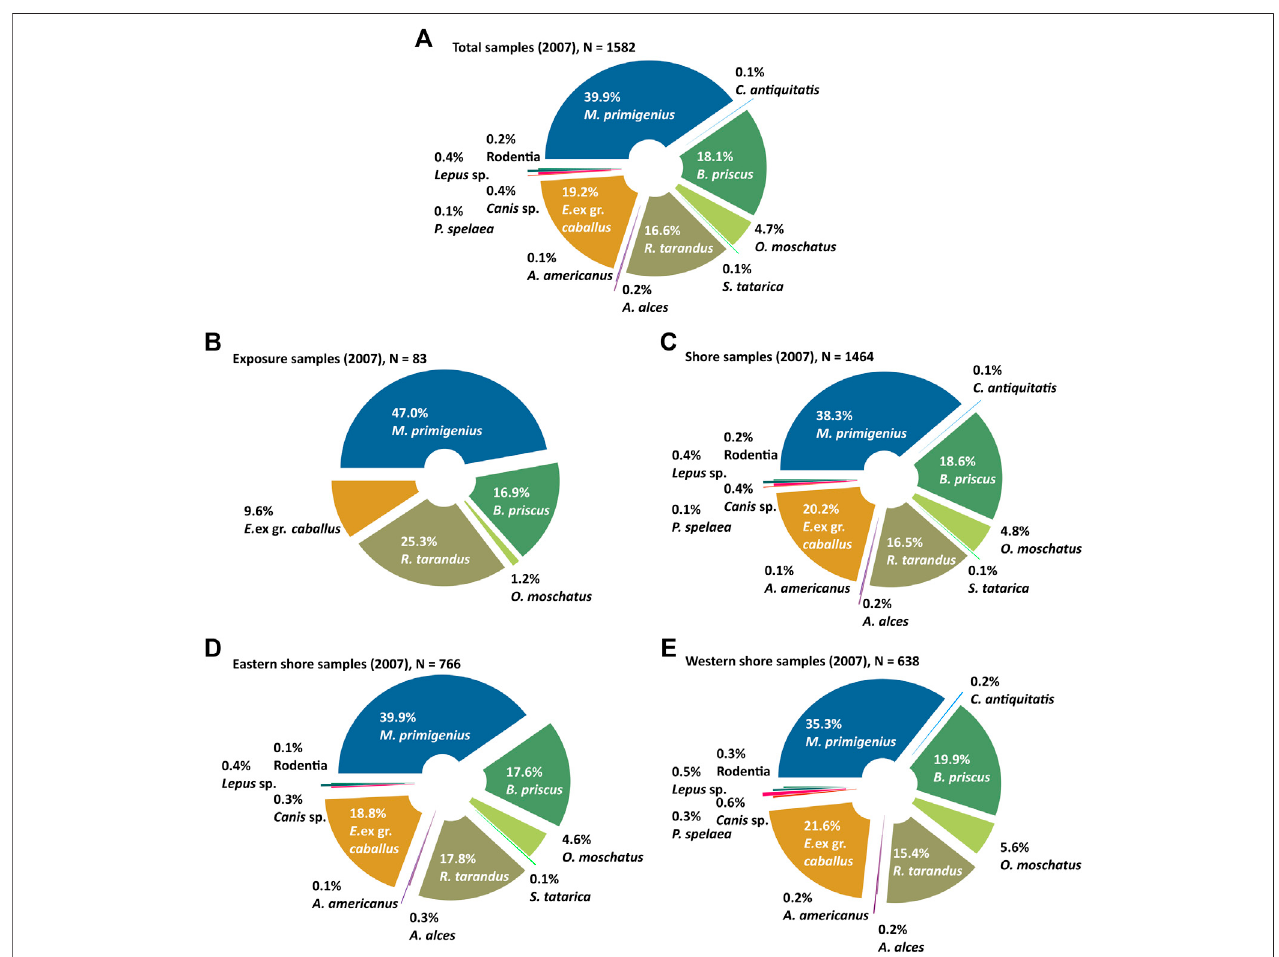
FIGURE 5 | Composition of the mammal bone collections from Oyogos Yar showing (A) the total collection from 2007 (N = 1582) differentiated into (B) the exposurecollection(N=83)and (C) theshorecollection(N=1464),whichisfurtherdifferentiatedinto (D) theeasternshorecollection(N=766)and (E) thewesternshore collection(N=638).Thepercentagesarecalculatedfromthetotalnumberofidenti fi edsamples( Table1 ).Note,that35bonesfoundatotherplacesand61bonesfound at other shore locations than (D) or (E) are summarized in (A) , but not differentiated in this fi gure. The full record is given in Table 1 .